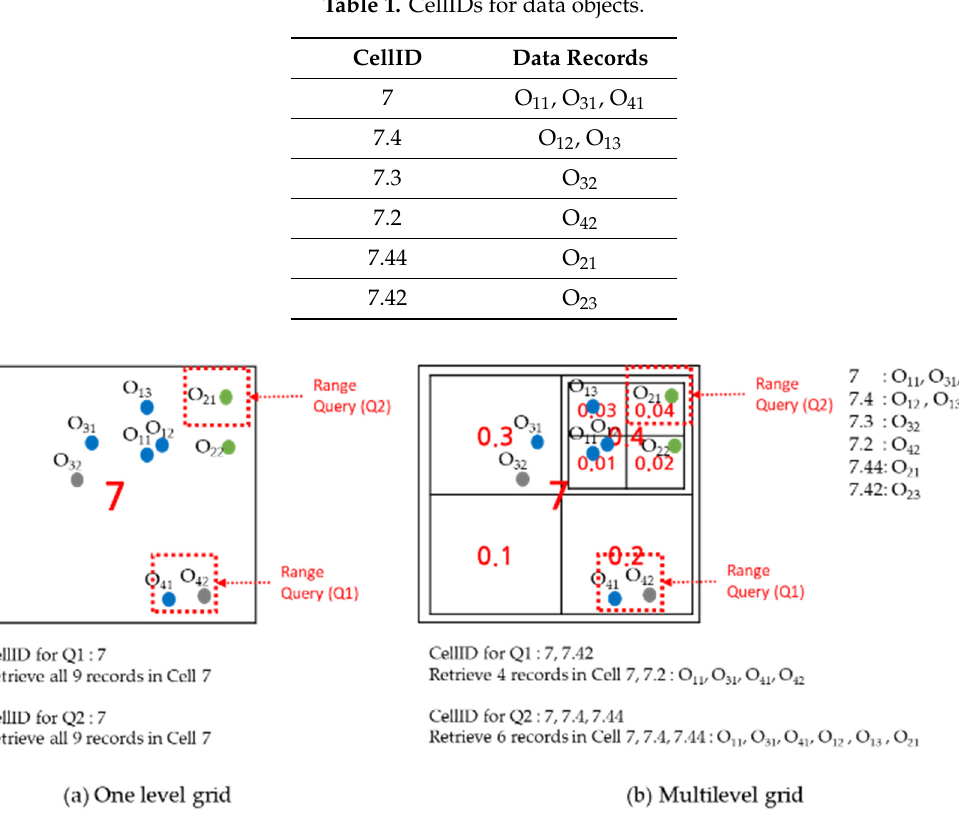
Figure 8. Query processing of dynamic grid indexing method.